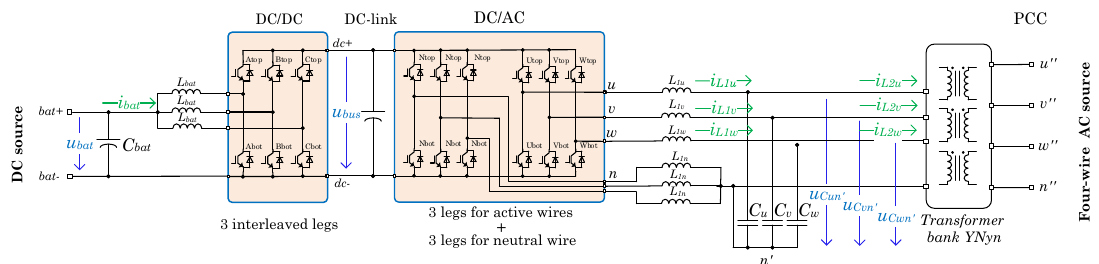
Figure 2. Scheme of the full direct current–direct current (DC–DC) and DC–AC proposed